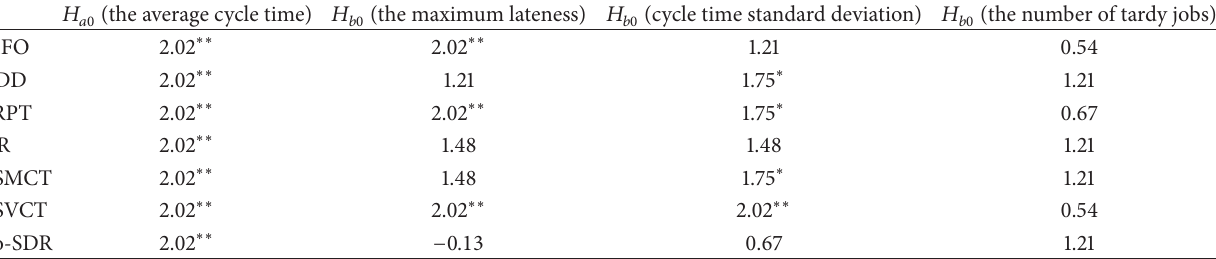
Table 12: Results of the Wilcoxon sign-rank